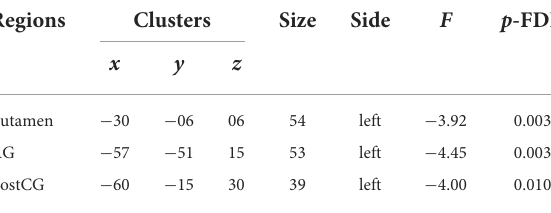
TABLE 2 Spatial map of SN for the contrast of PSA group vs. HC